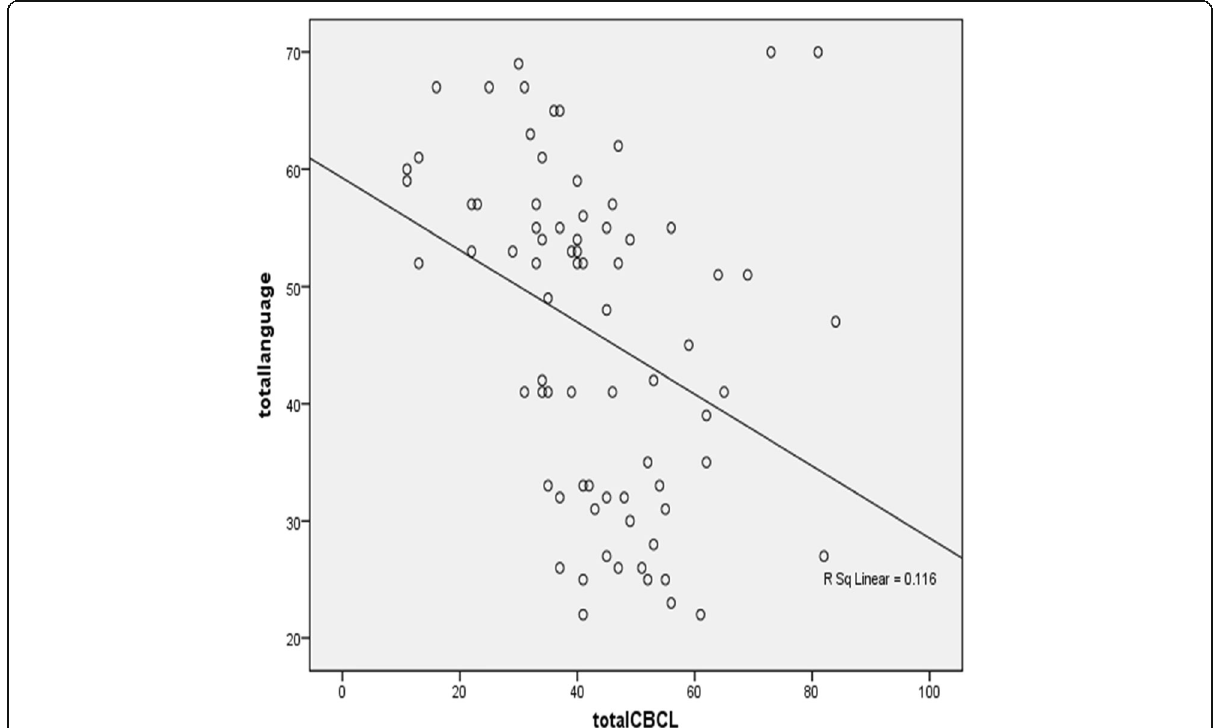
Fig. 7 Shows significant negative correlation between total language ages of all children (the three groups A, B, and C) and their total Child Behavior Checklist (CBCL) scores ( R =